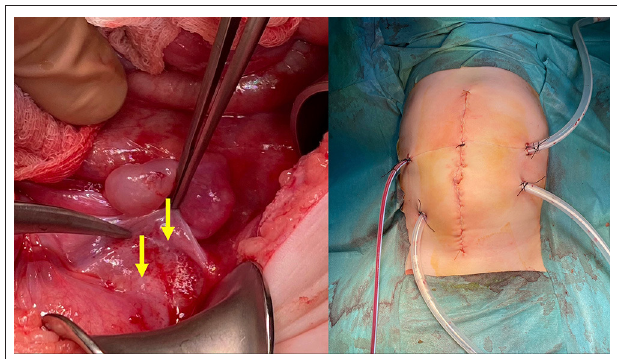
FIGURE 4 | On the left—intraoperative image: pelvic peritoneum with tumor implants (yellow arrows). On the right—abdomen during